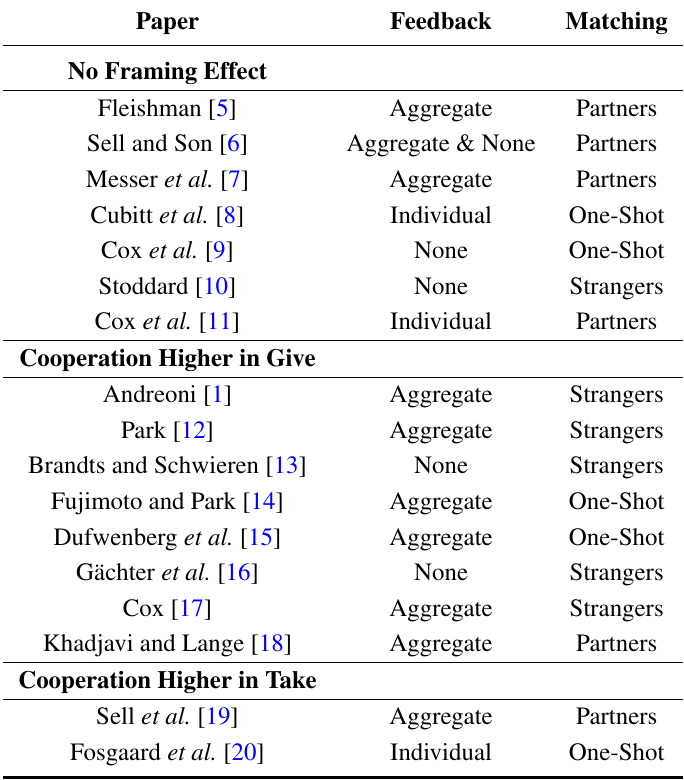
Table 1. Summary of Experiments on Give/Take Framing in Linear VCM Game.